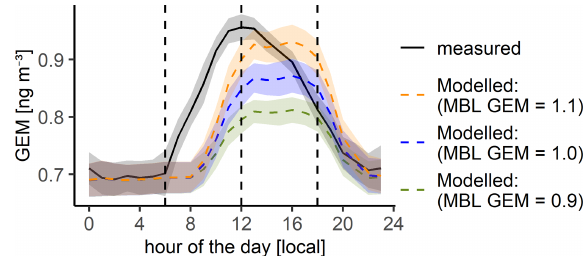
Figure 6. Assessment of the role of mixing between LFT and MBL as a driver for diurnal GEM cycles. The solid line shows the ob- served mean diurnal GEM cycle for those days characterized by an especially marked diurnal GEM variation (Group 1). The dashed lines give the corresponding modeled diurnal GEM cycles if only the diurnal variation in the sampled mix of LFT and MBL air is considered, under the assumption of no surface influence from the island. Modeled diurnal cycles based on three different MBL con- centrations (1.1, 1.0, and 0.9ngm − 3 ) are shown. Shaded areas give the arithmetic mean ± 2 times the standard